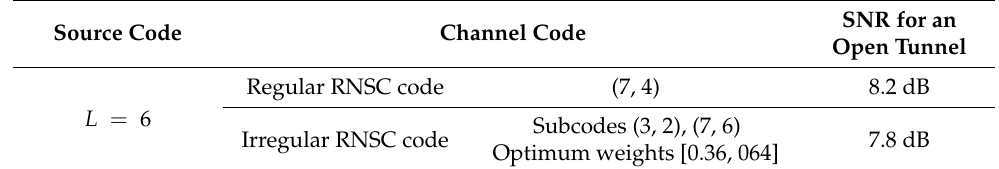
Table 2. Parameters of channel code matched with L = 6 source code.